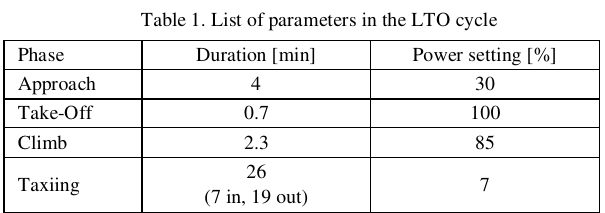
Table 1. List of parameters in the LTO